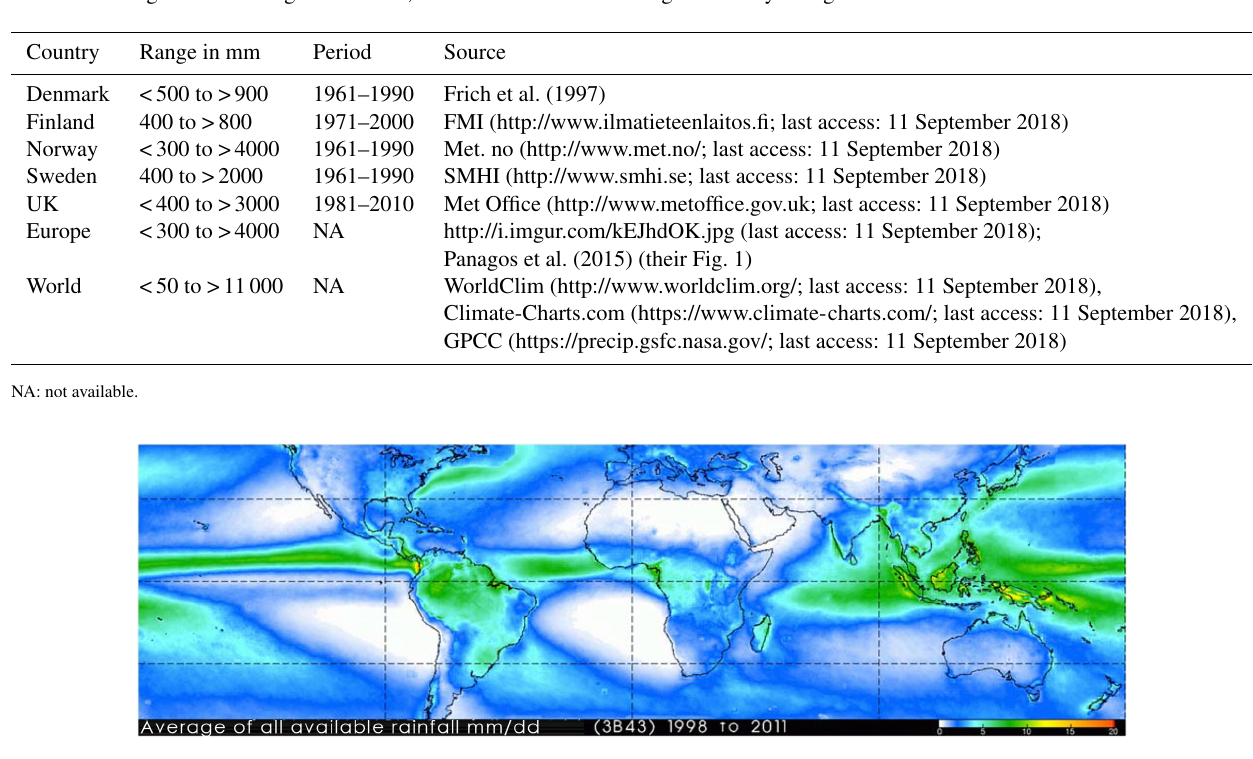
Table 2. Mean annual precipitation ranges over land in selected countries, Europe and the world. FMI: Finnish Meteorological Institute; Met. no: Norwegian Meteorological Institute; SMHI: Swedish Meteorological and Hydrological Institute.